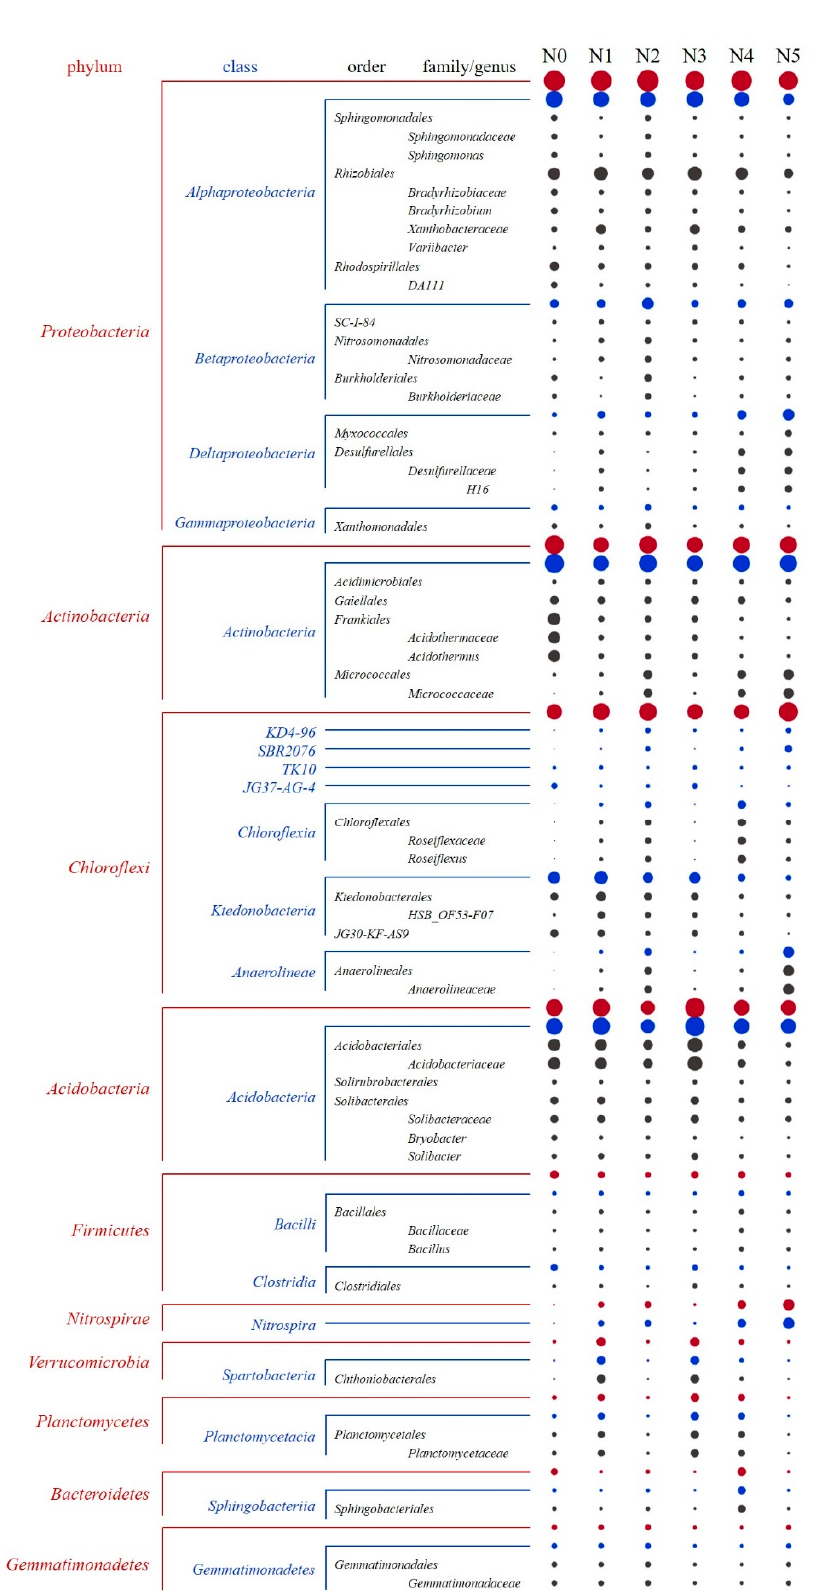
Figure 5. The response of bacterial community structure in different taxonomical levels to nitrogen gradient (only shown the sequence of bacteria > 1% of all sequences). The size of the circle represented the relative abundance of bacteria at each treatment, and the color of the circle represents bacterial taxonomical levels: red is phylum; blue is class; black is order, family, and genus.